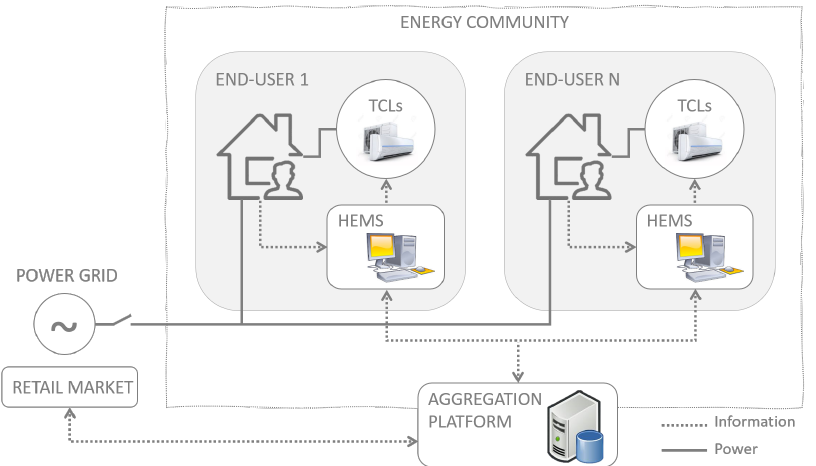
Figure 1. System model considered in this study. Each consumer has TCLs controlled locally by his/her ECC, which is part of a HEMS that communicates with the other HEMSs and with the aggregation